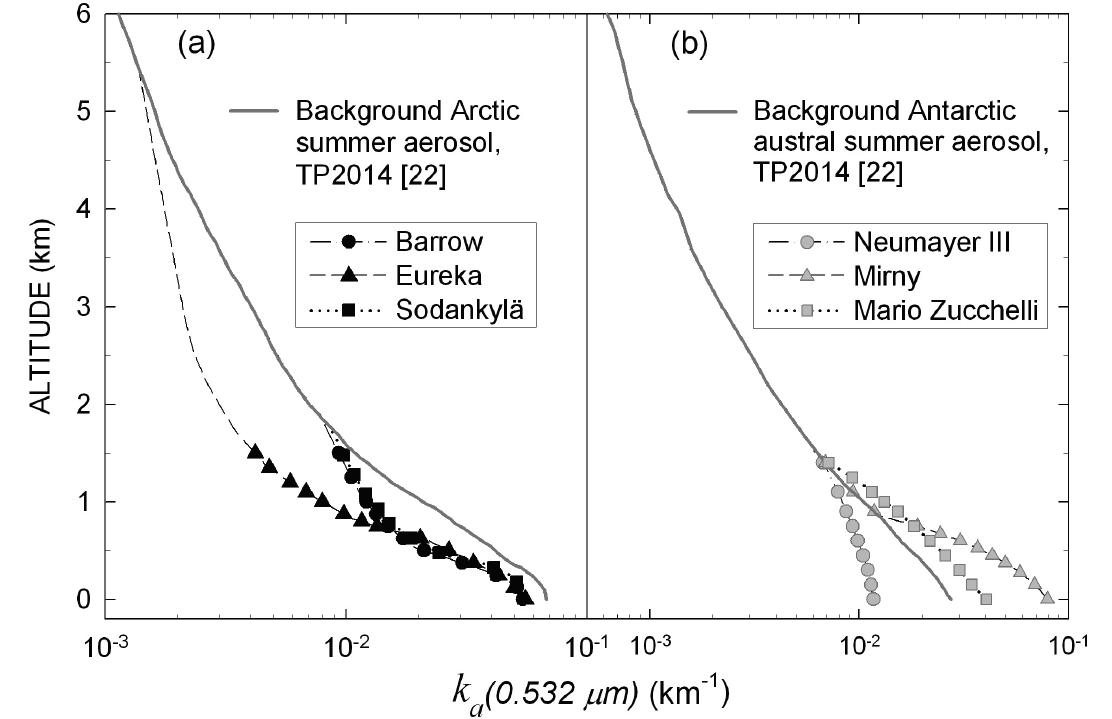
Figure 3. Left-hand side ( a ): Seasonal mean vertical profiles of aerosol volume extinction coefficient k a ( 0.532  m ) determined from daily CALIPSO measurements of volume aerosol backscattering coefficient B bs ( 0.532  m ) conducted at Barrow (~71°N), Eureka (~80°N) and Sodankylä (~67°N) during the summer (June-September) months of 2013 and 2014. Right-hand side ( b ): As in the left-hand side, for the sets of CALIPSO measurements conducted at Neumayer III (~71°S), Mirny (~67°S) and Mario Zucchelli (~75°S), Terra Nova Bay, Ross Sea) in Antarctica during the austral summer (November–February) months of 2013 and